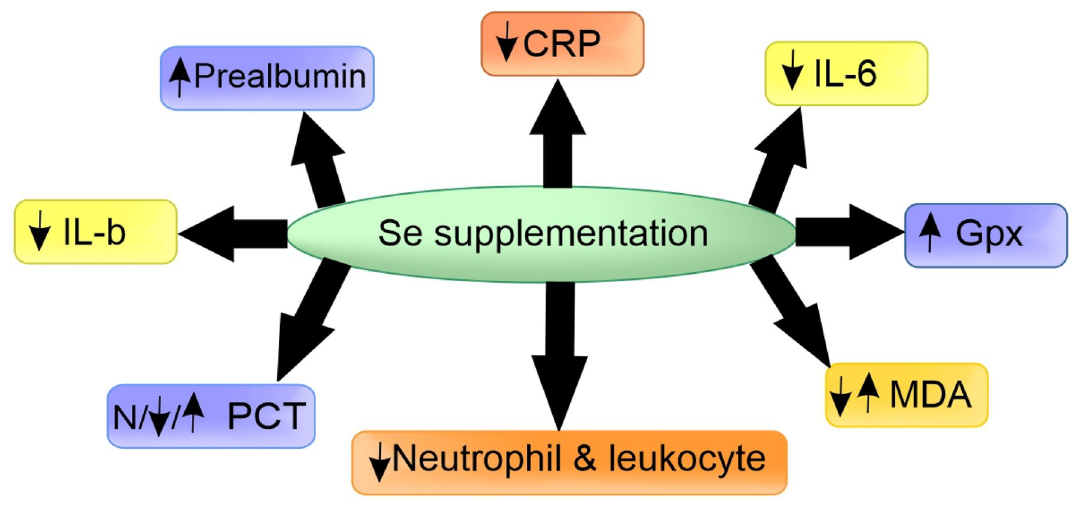
Fig. 1 Schematic view illustrating the effects of Selenium supplementation on inflammatory markers in critically ill